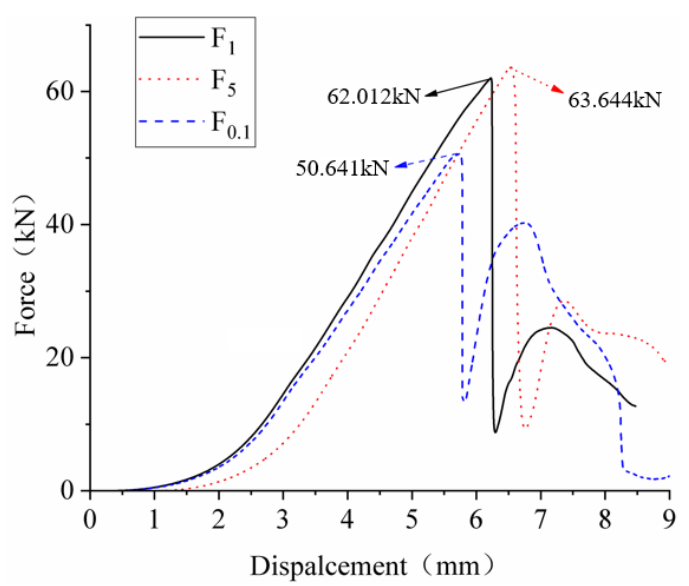
Figure 5. Battery load displacement curve under different extrusion speeds.